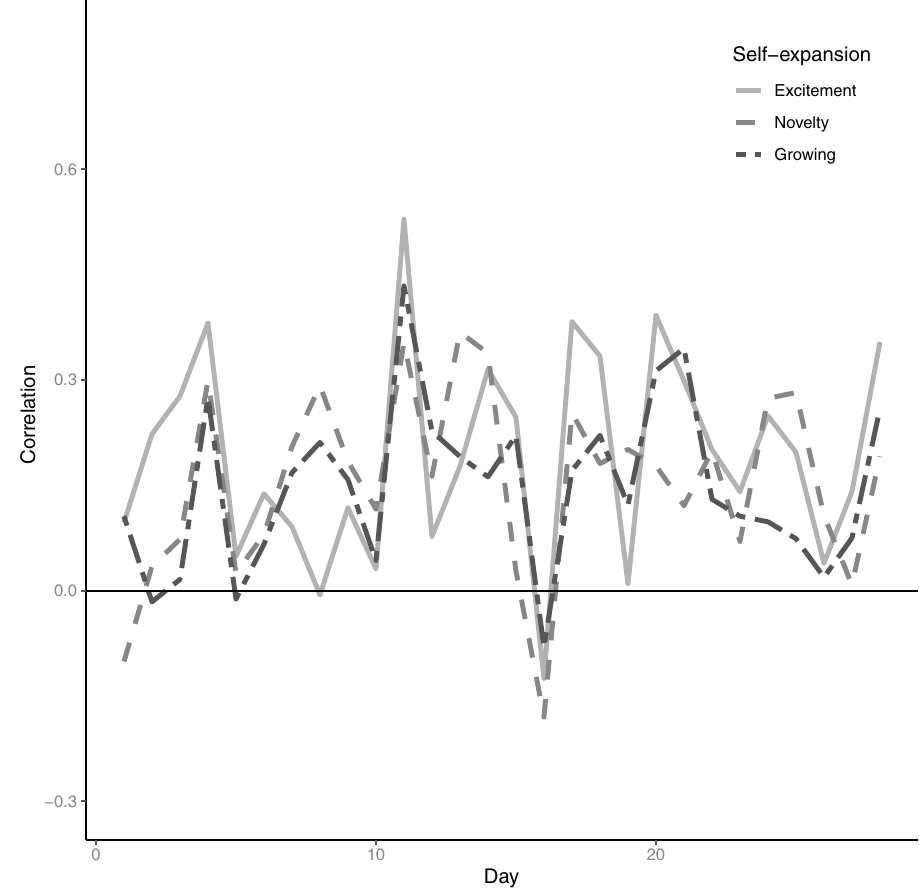
Figure 1. Daily correlations between daily steps and general self-expansion variables (solid light gray is self-expansion excitement, dashed gray is self-expansion novelty, and double-dash dark gray is self-expansion